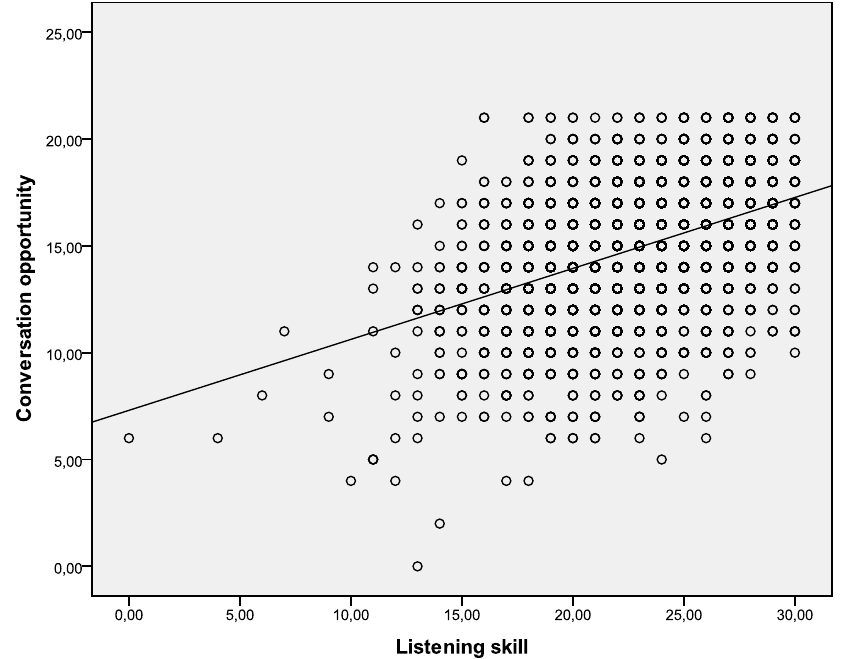
Figure 3. Scatter plot for the association of Listening Skill with Conversation Opportunity.